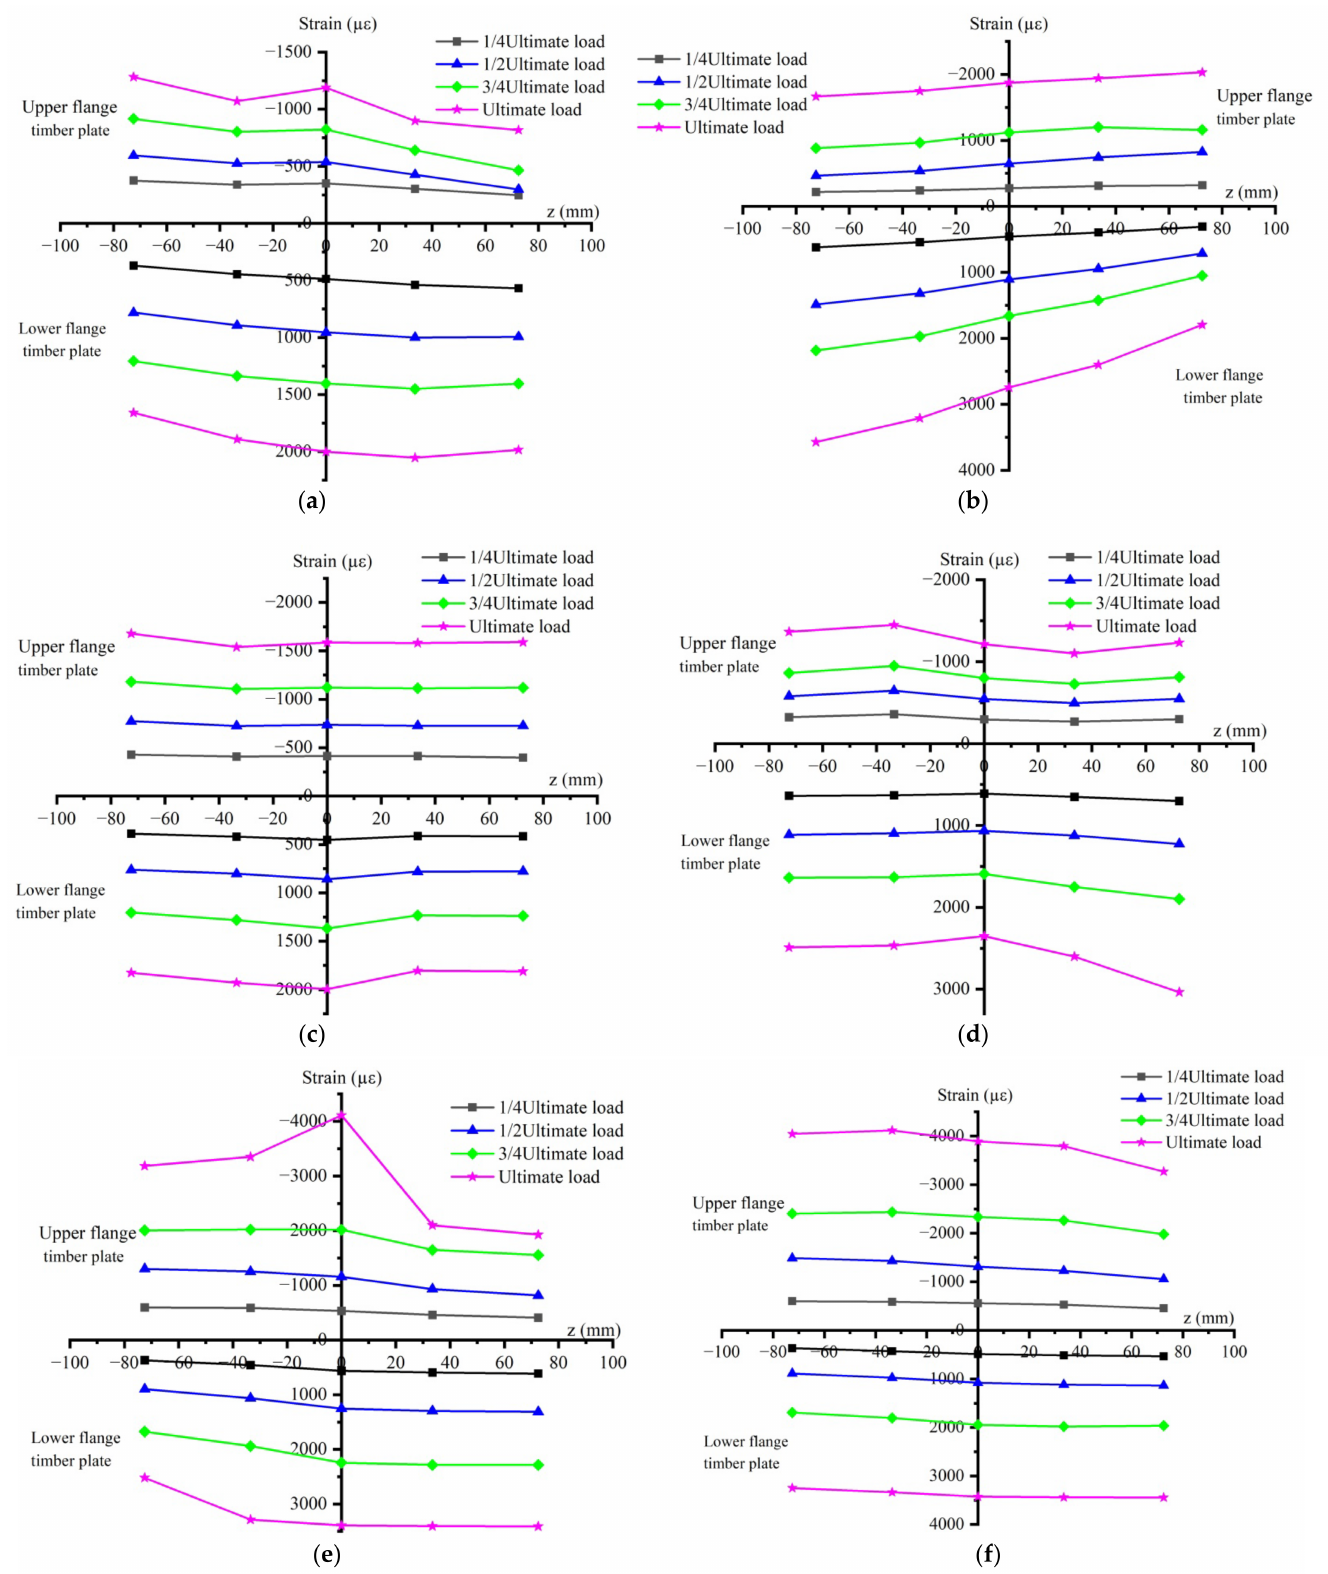
Figure 11. Lateral distribution of normal strains in the upper and lower timber boards of the mid-span section: ( a ) L1-1; ( b ) L1-2; ( c ) L2-1; ( d ) L2-2; ( e ) L3-1; ( f )